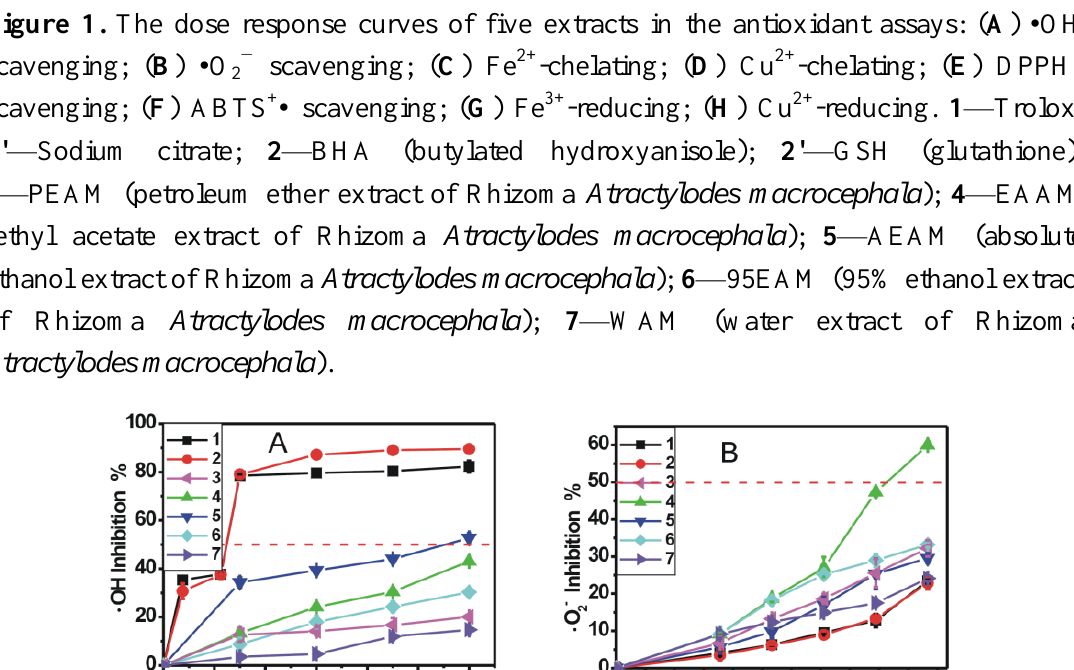
Figure 1. The dose response curves of five extracts in the antioxidant assays: ( A ) •OH scavenging; ( B ) •O 2− scavenging; ( C ) Fe 2+ -chelating; ( D ) Cu 2+ -chelating; ( E )